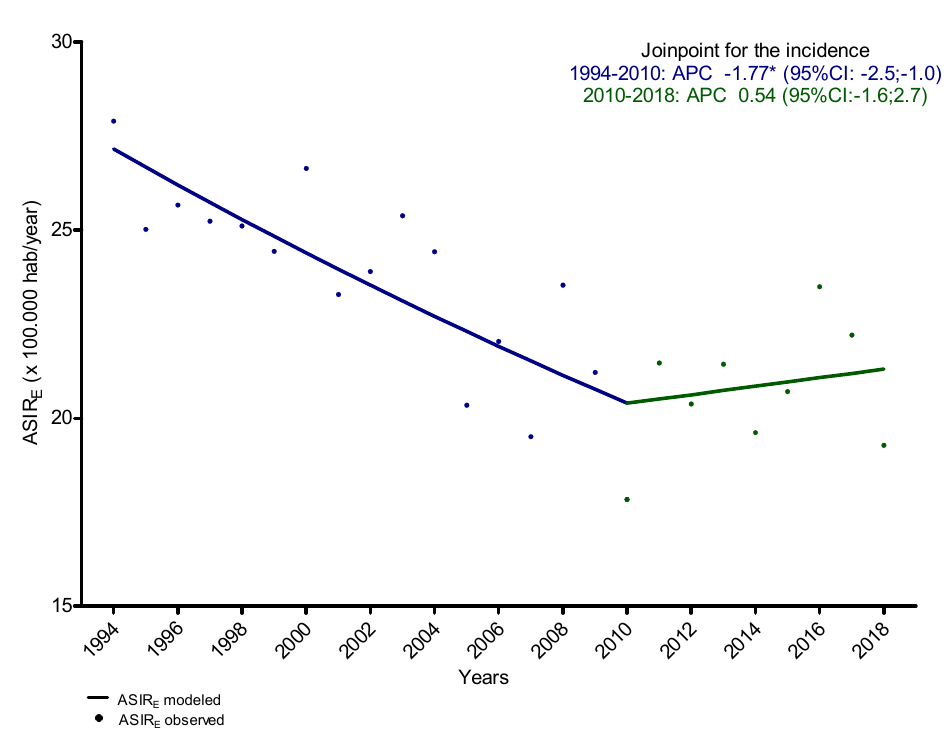
Figure 1. Trends in incidence of overall head and neck cancer, from 1994 to 2018. Joinpoint analysis of age-standardized to the European population incidence rates (ASIR E ) assessing specific turning points. APC: Annual Percentage Change. * statistically significant.